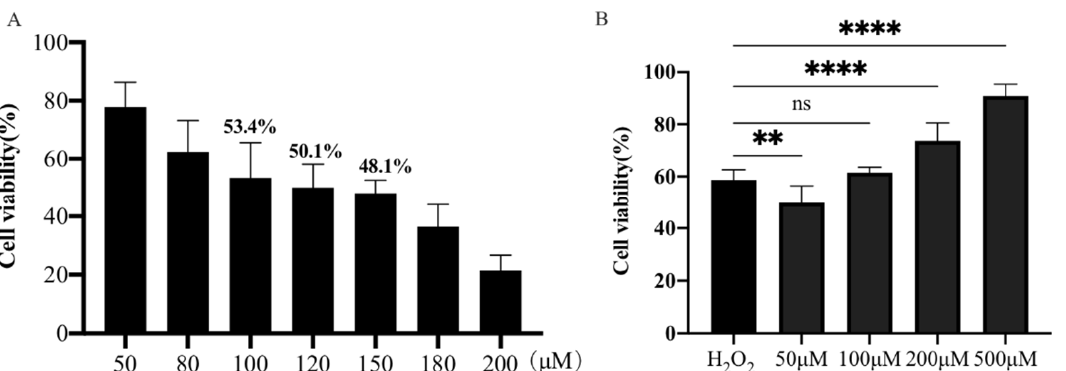
Figure 1. Effect of H 2 O 2 on antioxidant properties of PTr2 cells. ( A ) The PTr2 cells were treated with different concentrations of H 2 O 2 for 4 h, and then the cell vitality was detected using a CCK-8 assay. ( B ) The PTr2 Cells were cultured with different concentrations of MT for 24 h before incubated with 120 µ M H 2 O 2 for 4 h and cell viability was detected using a CCK-8 assay. The data are expressed as the means ± SEM from at least 6 separate experiments. p < 0.05 was considered to be statistically significant. p > 0.05 (ns), p < 0.01 (**), p < 0.0001